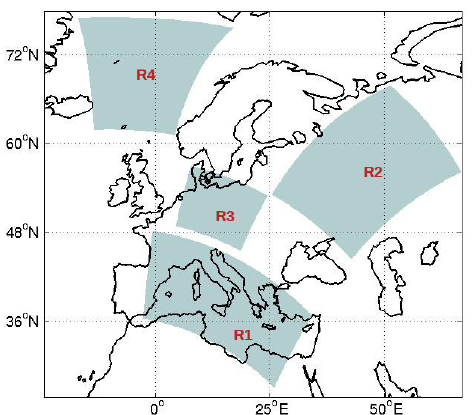
Figure 5. Schematic of the four regions selected for this study. R1 – Mediterranean; R2 – eastern Europe; R3 – central Europe; R4 – northern Atlantic.